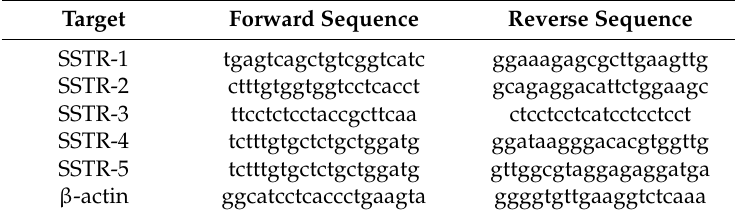
Table 2. The sequences of SSTR-1, -2, -3, -4, -5 and β -actin primers used for qRT-PCR